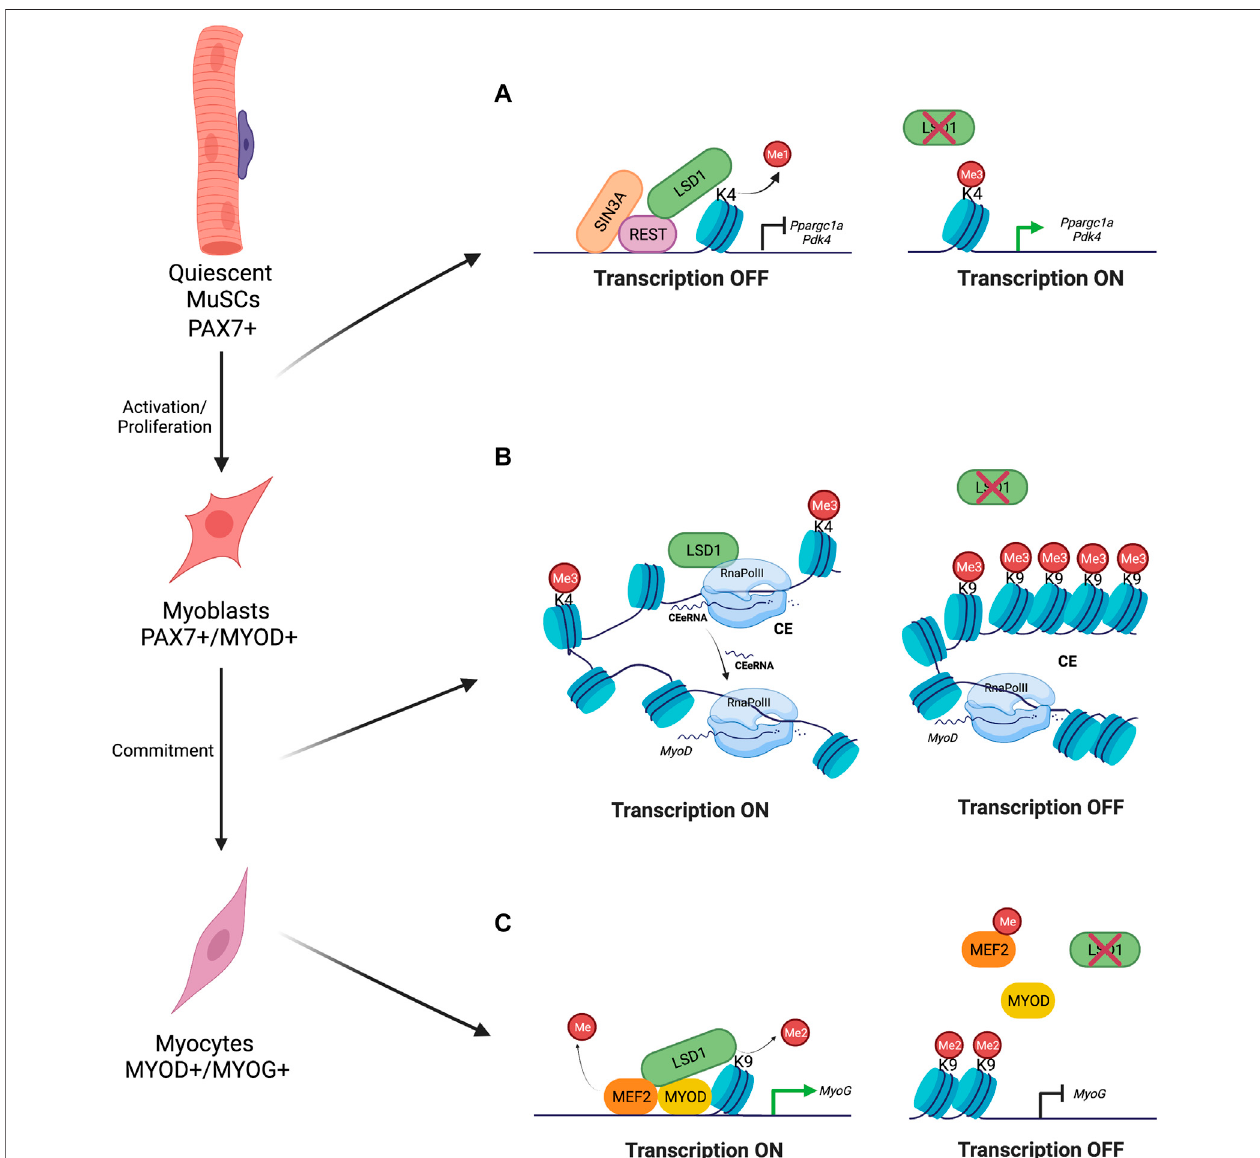
FIGURE1 | LSD1 Demethylase Regulationof Myogenesis. (A) During MuSCs activation and proliferation, LSD1 isenriched on promoters ofoxidativemetabolism genes, together with repressive factor Sin3A and REST. Here, it removes H3K4me2 marks resulting in transcription repression. LSD1 absence results in activation of oxidative metabolism genes transcription (Anan et al., 2018). (B) During myoblast commitment, LSD1 demethylase is recruited on MyoD core enhancer (CE), where it promotes the transcription of the CEeRNA. LSD1 ablation results in H3K9me3 methyl marks accumulation and repression of the CEeRNA transcription (Scionti et al., 2017). (C) During skeletal muscle differentiation, LSD1 associates with MYOD and MEF2 on Myogenin promoter. LSD1 directly demethylates MEF2D protein and removes H3K9me2 marks promoting MyoG expression. LSD1 depletion results in H3K9me2 accumulation thus inhibition of MyoG transcription (Choi et al., 2010; Choi et al.,